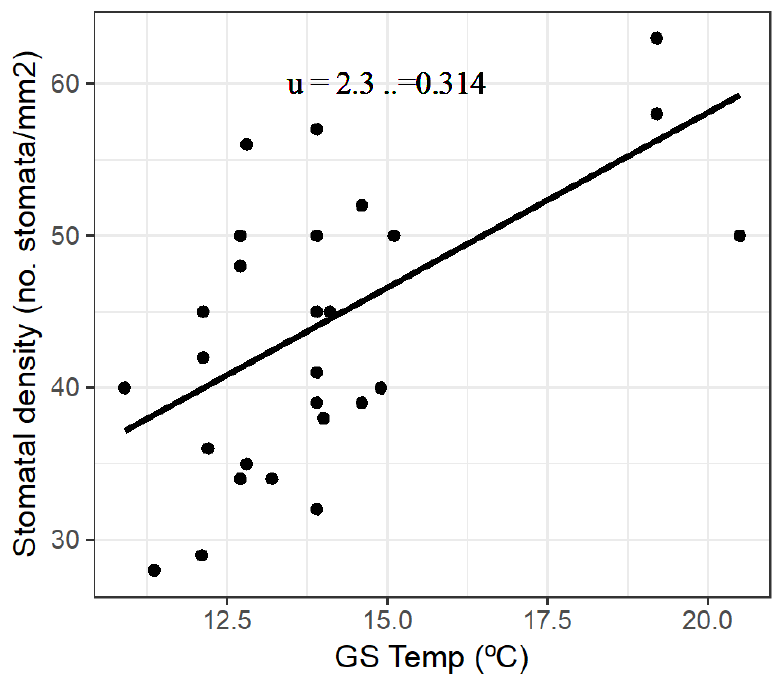
Figure S1. Linear regression of the relationship between the stomatal density (no. stomata/mm 2 ) and the variation in temperatures during the growing season (ºC) of Senecio pyrenaicus subsp. carpetanus found in conserved specimens.